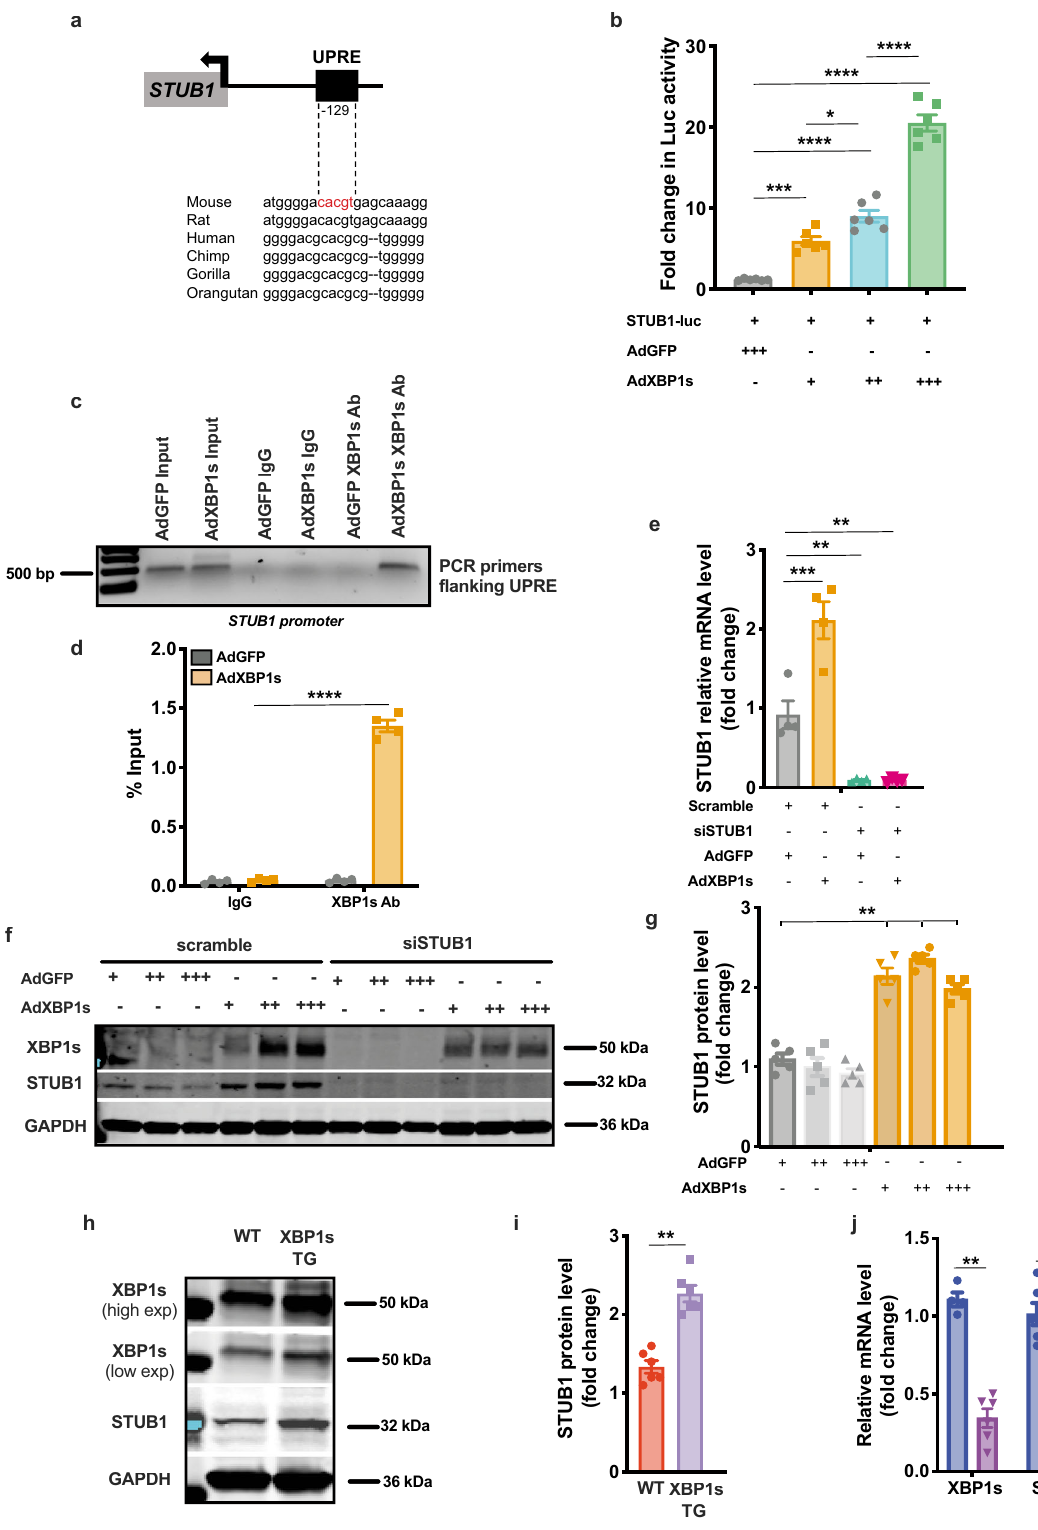
biogenesis, decreased FA oxidation, or a combination of the two. In the hearts of obese humans and rodents, an increase, rather than a decrease, in FA oxidation has been reported 27,28 . Con- versely, impaired FA oxidation is a hallmark of metabolic dys- function in HF. In patients with HFrEF without metabolic abnormalities (i.e., diabetes and obesity) only a minimal